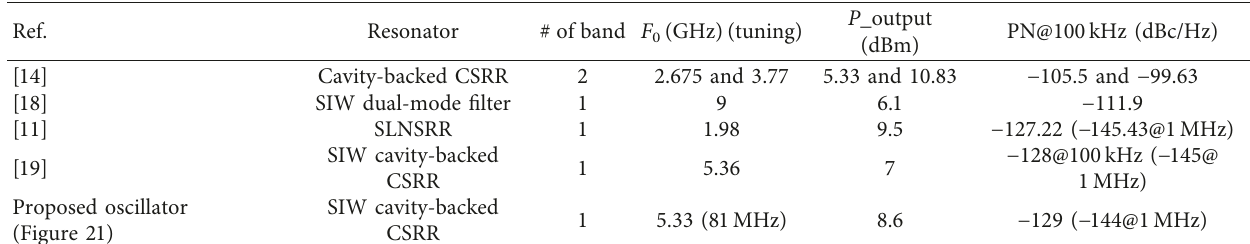
Figure 22: Measured and simulated phase noise for the proposed Table 3: Comparison with other reported microwave planar hybrid oscillator.